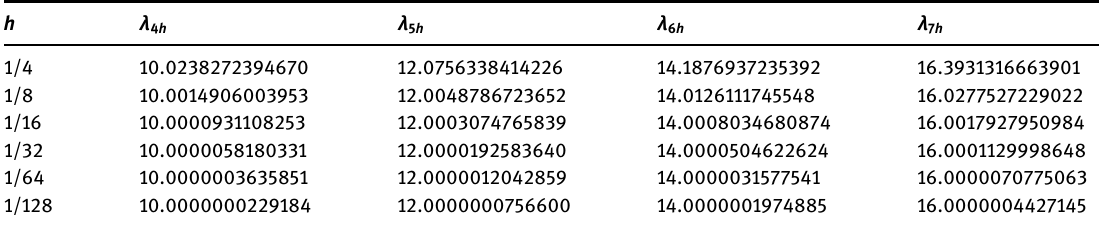
Table 3: Eigenvalues for = m 4, 5, 6, 7 and di ff erent